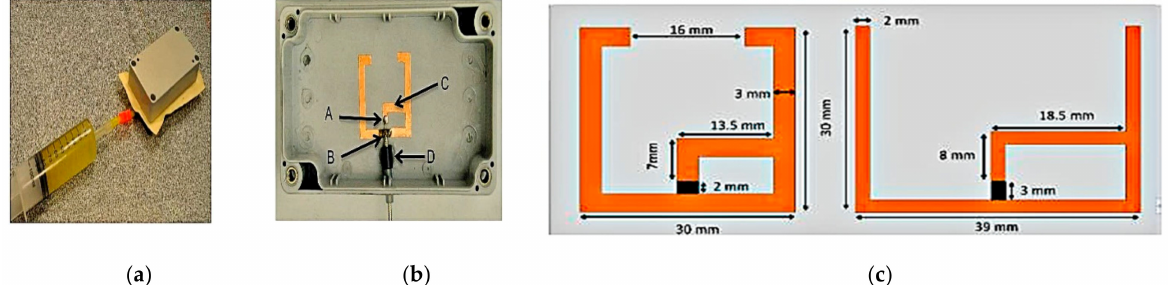
Figure 33. ( a ) Plastic antenna box, latex diaphragm, and syringe. ( b ) Bent dipole antenna and coaxial cable arrangement. ( c ) Dimensions of the two bent dipole antennas with castor oil (on the left) and ethyl acetate (on the right) [59].